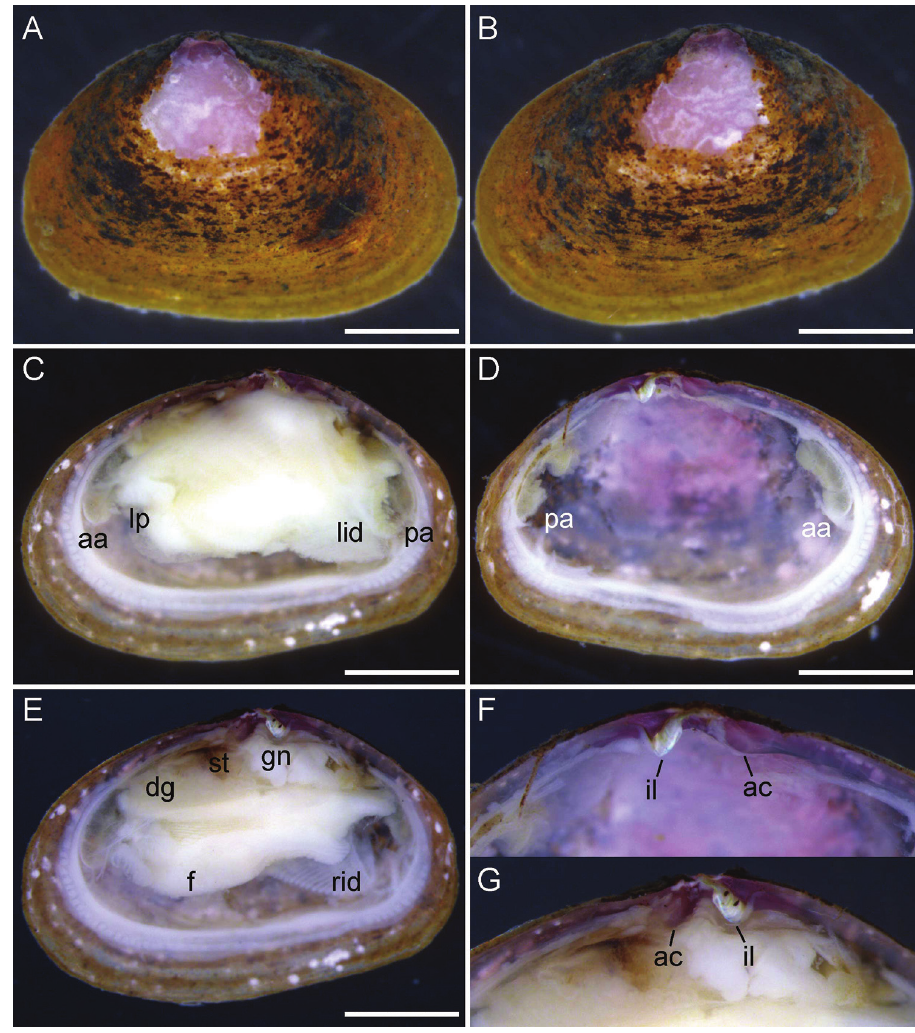
Figure 2. Holotype of Borniopsis mortoni (UMMZ 305035) (SL 4.1 mm). A, C, E Right valve B, D Left valve F, G Hinge structure of left and right valves. Abbreviations: aa, anterior adductor muscle; ac, anterior cardinal tooth; f, foot; gn, gonad; il, internal ligament; lid, inner demibranch of left side; pa, pos- terior adductor muscle; rid, inner demibranch of right side; st, stomach. Scale bars 1 mm. Photo credits: R. Goto: A–G